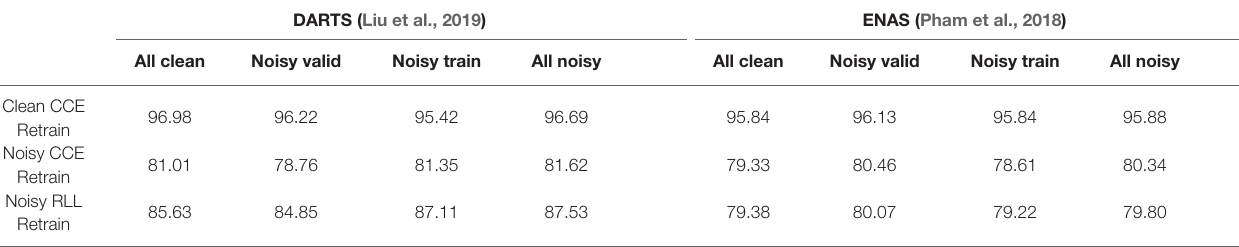
TABLE 1 | NAS on CIFRA-10 with symmetric noise ( η = 0.6).